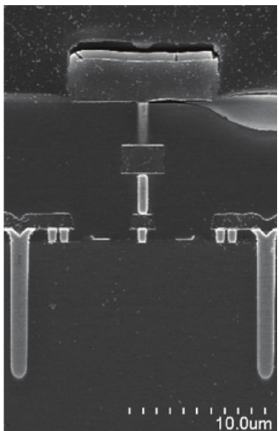
Figure 3: Cross-sectional SEM view of the fabricated RF